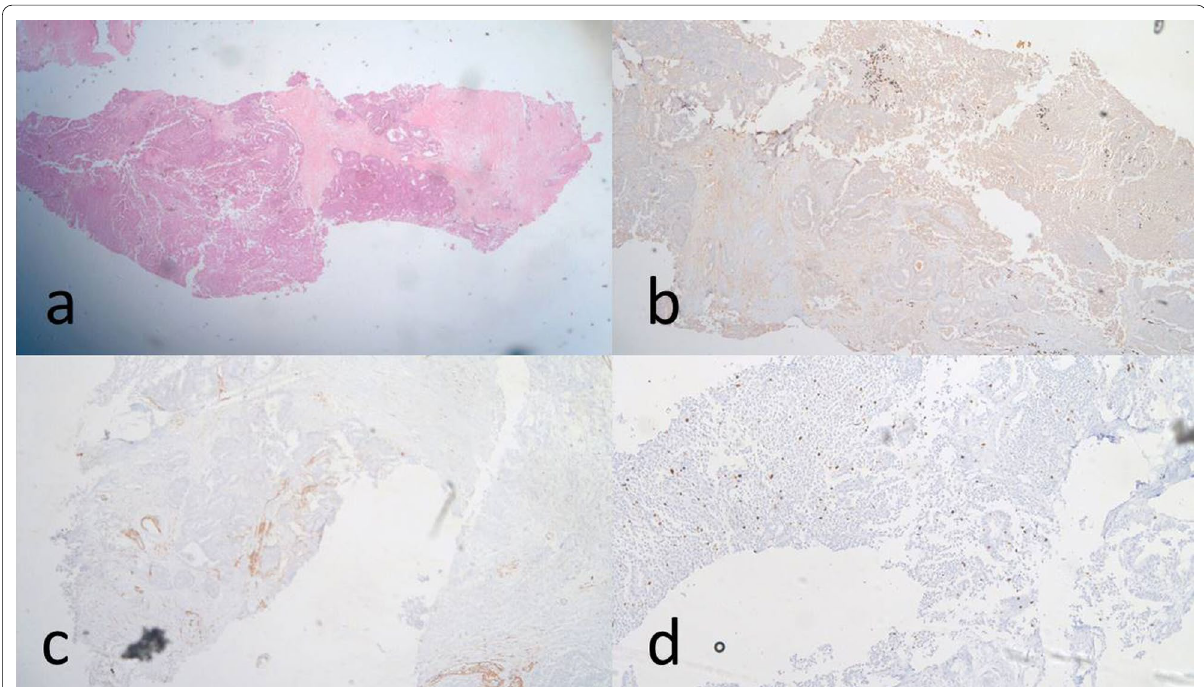
Fig. 4 The tumor cells showing papillary pattern ( a ). Immunohistochemistry showing tumor cells negative for P63 ( b ), calponin ( c ), with a Ki67 score of 10% ( d